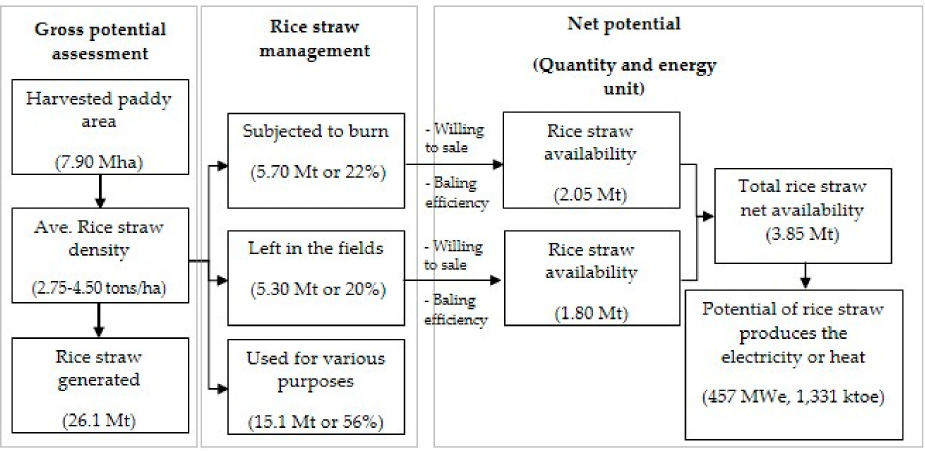
Figure 12. Material flow diagram of rice straw residue for energy-related purposes.